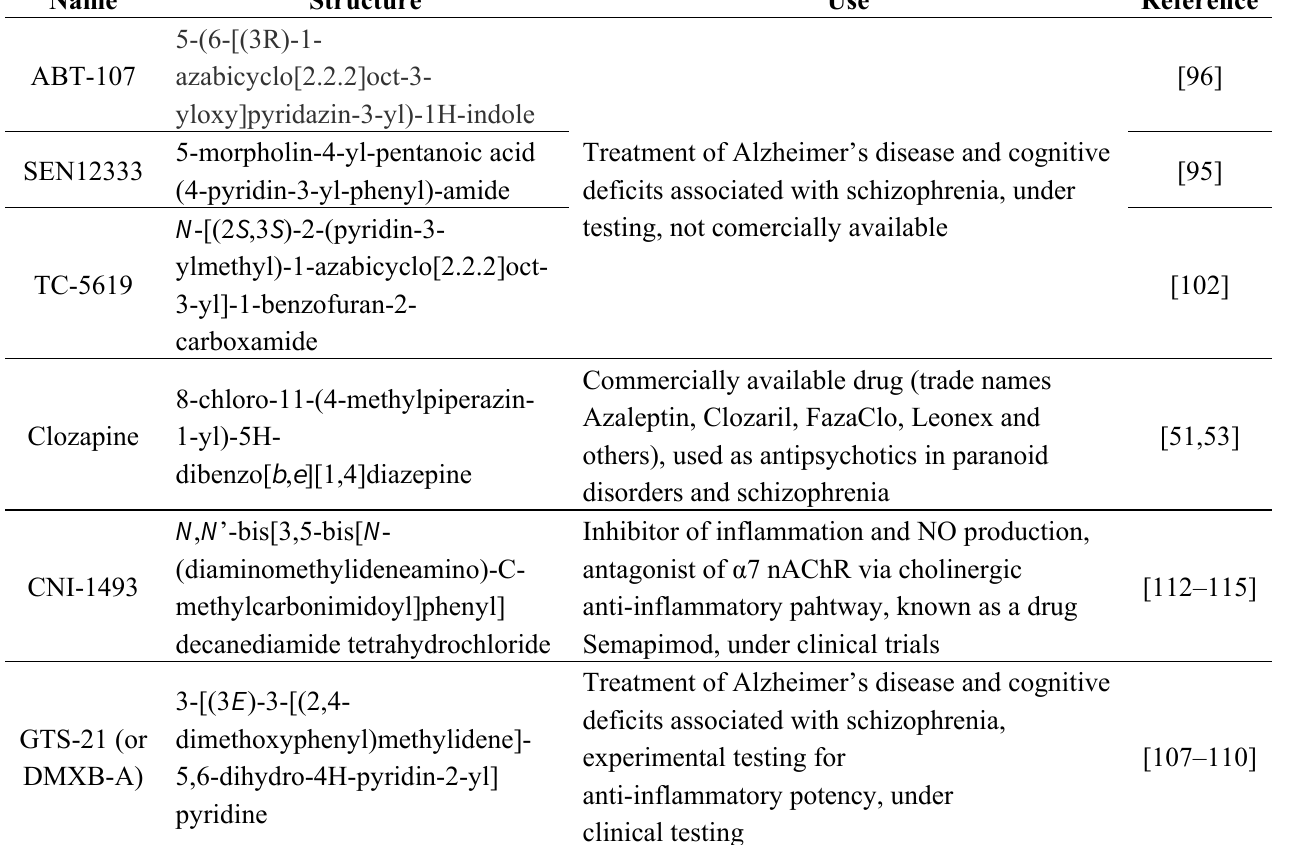
Table 2. Overview of selected α 7 nAChR